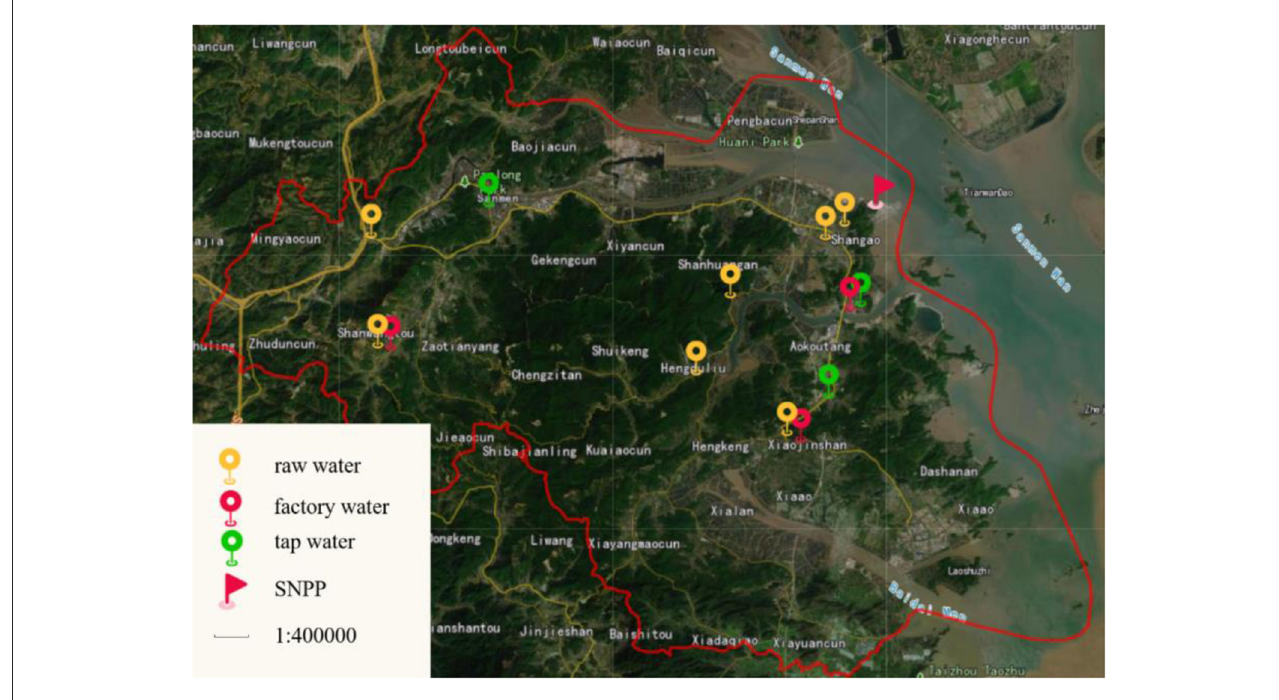
FIGURE1 Sampling stations of drinking water around SNPP.